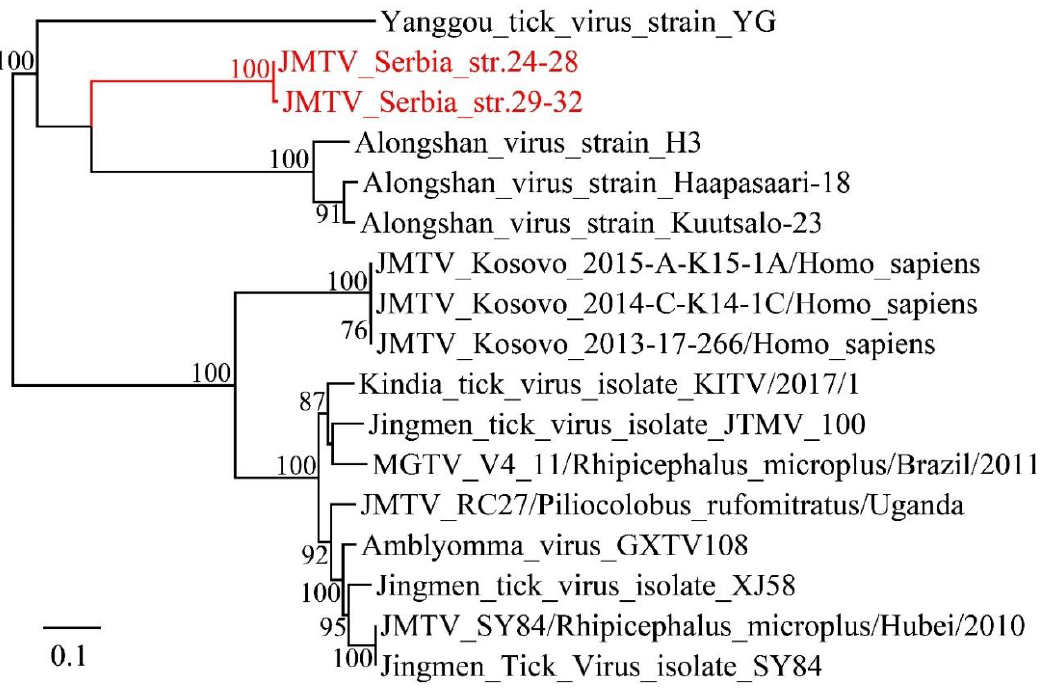
Figure 4. Phylogenetic analysis of the Jingmen tick viruses. The phylogenetic trees were inferred using the ML method, with 1000 bootstrap replicates and mid-point rooting.